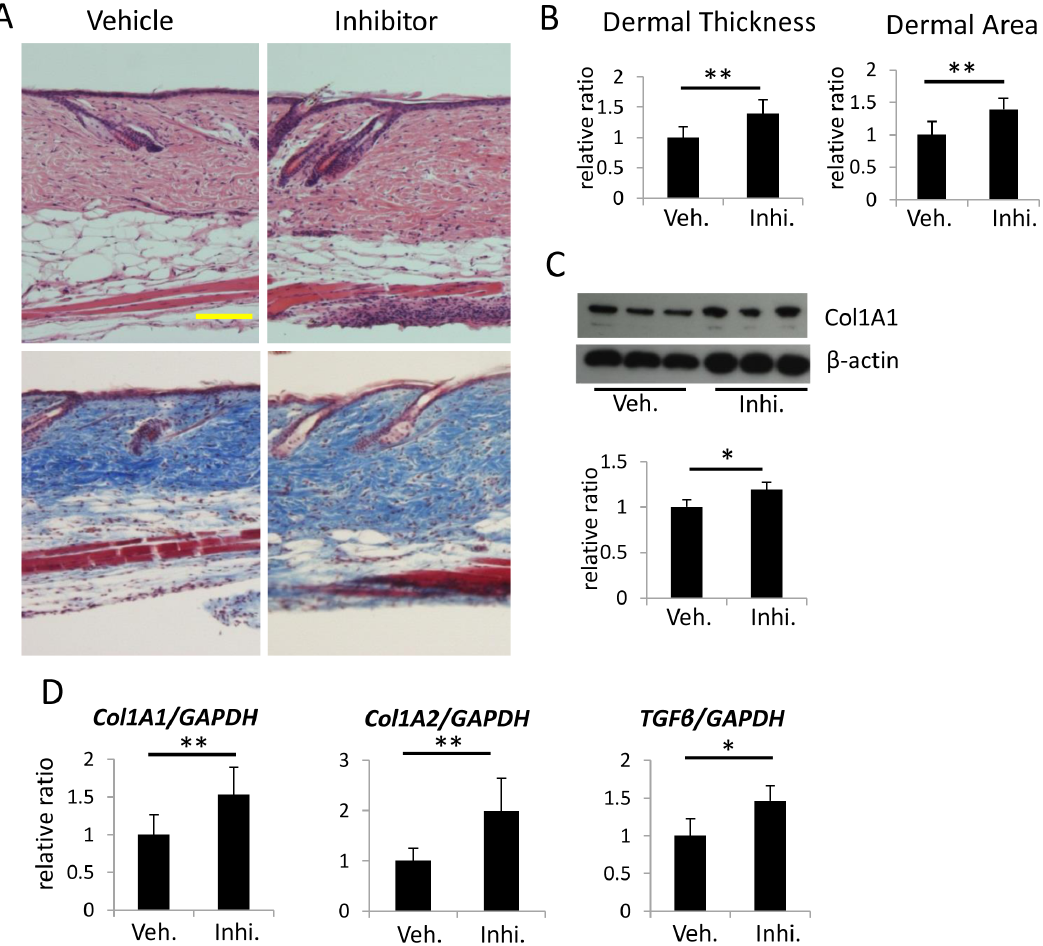
Figure 2. Effects of 11 b -HSD1 inhibition on dermal thickness and expression of a collagen-associated gene in 7-week-old C57BL/6 mice. (A) Representative H&E and Masson’s trichrome staining of 11 b -HSD1 inhibitor-treated and vehicle-treated mouse skin (N=6 per group). Bar =100 m m. (B) Dermal thickness and the dermal area of 11 b -HSD1 inhibitor-treated and vehicle-treated mice. Dermal thickness was calculated by averaging the thickness measured at five locations in each section. Three sections from each mouse were evaluated. The dermal area in each mouse was measured using Image J. Bars show the mean epidermal thickness 6 SD (N=6; *P , 0.01, Student’s t-test). (C) Western blot analysis of Collagen type 1 expression in mouse skin from three individual animals treated with the 11 b -HSD1 inhibitor or vehicle. Bars show the results of densitometric analysis relative to b -actin. Mean 6 SD of each group are shown. (N=3 *P , 0.05, Student’s t-test.) (D) The relative expression of Col1A1, Col1A2 and TGF b 1 in 11 b -HSD1 inhibitor-treated and vehicle-treated mouse skin was assessed with rtPCR. GAPDH was used as an internal control. Bars indicate the mean 6 SD (N=6; *P , 0.05, **P , 0.01, Student’s t-test).